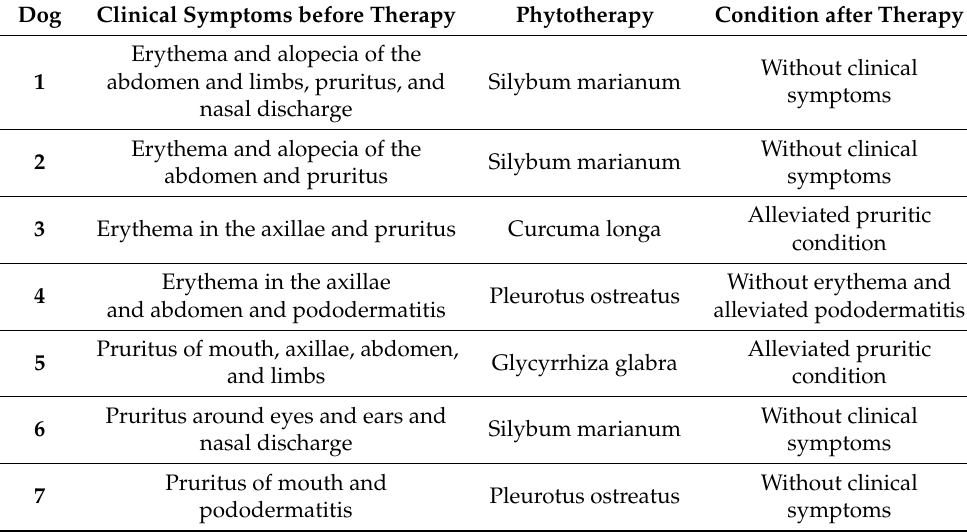
Table 2. Clinical symptoms before therapy, and condition after application of acupuncture and phytotherapy in the first observed group.